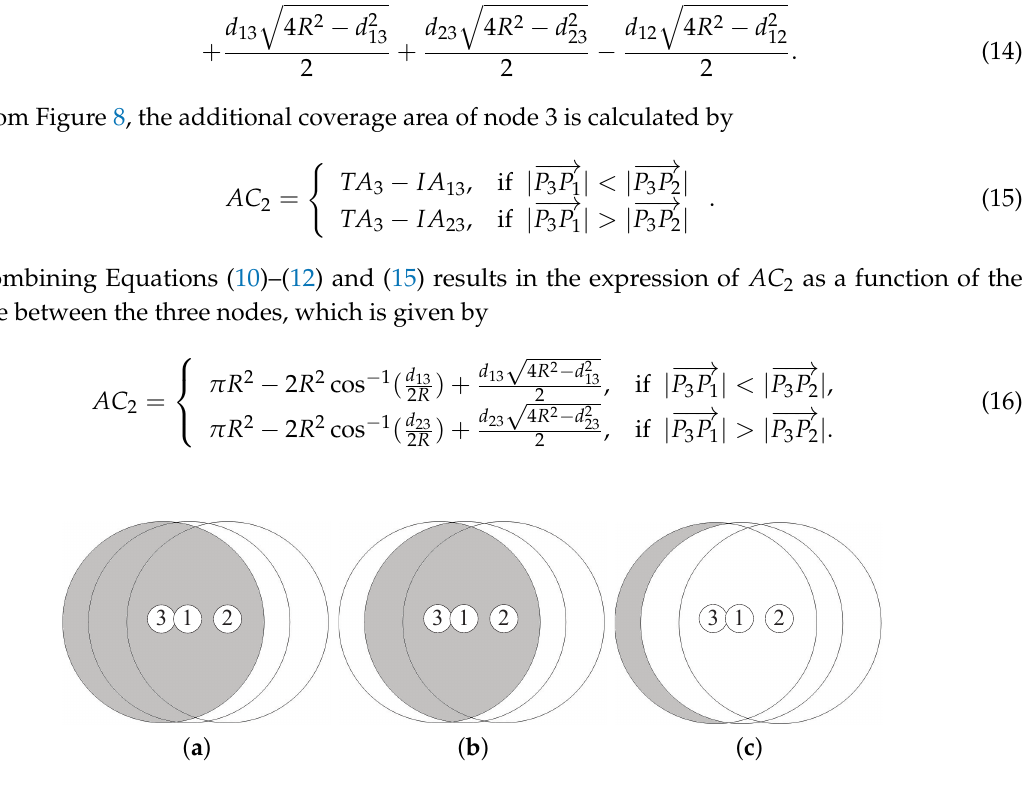
Figure 8. The additional coverage area of node 3 in case 2. ( a ) TA 3 ; ( b ) IA 13 ; ( c ) AC 2